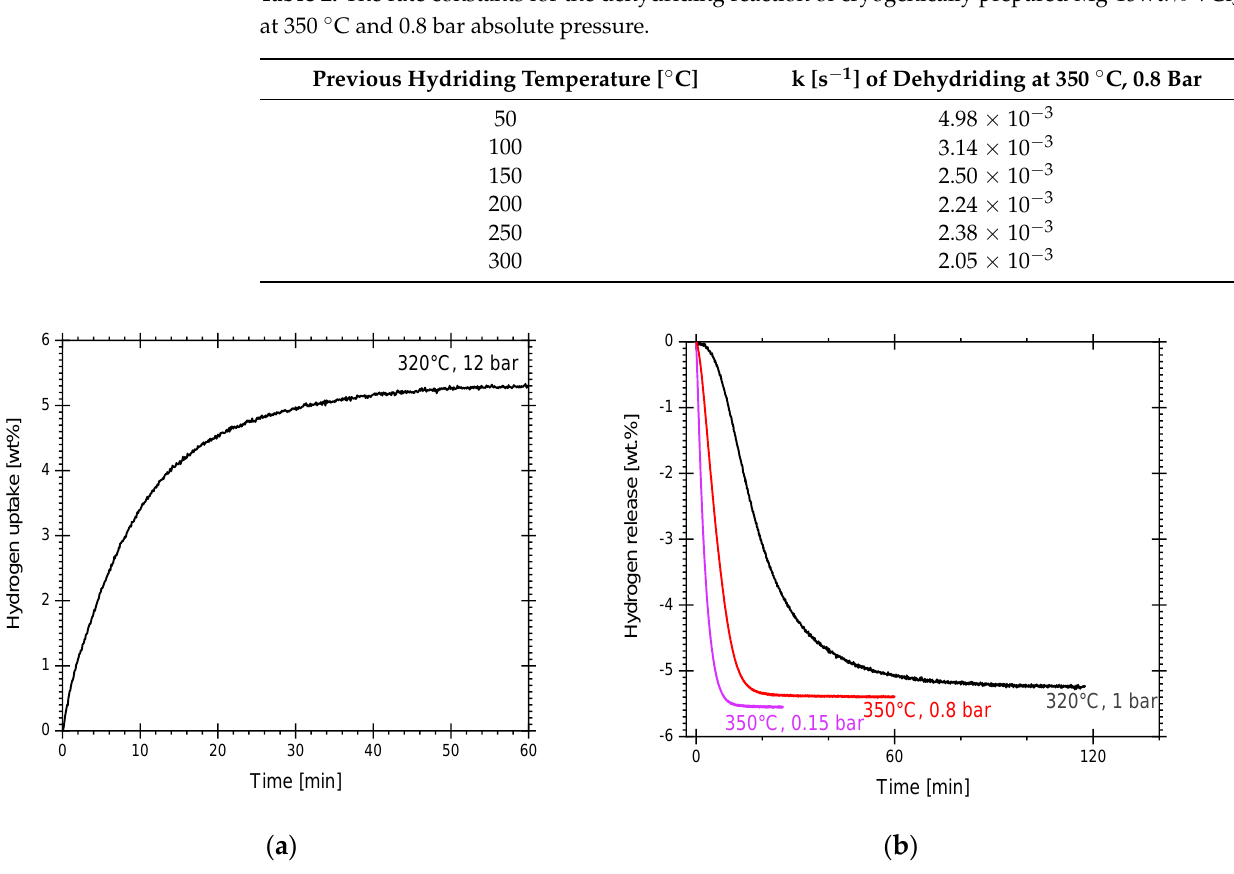
Figure 4. Hydriding/dehydriding cycles of cryogenically prepared Mg-15wt.% VCl 3 . ( a ) Isothermal hydriding at 320 °C/12 bar. ( b ) Isothermal dehydriding at 320 °C/1 bar. For comparison, isothermal dehydriding at 350 °C/0.15 bar and 350 °C/0.8 bar (red line of Figure 3) were included.